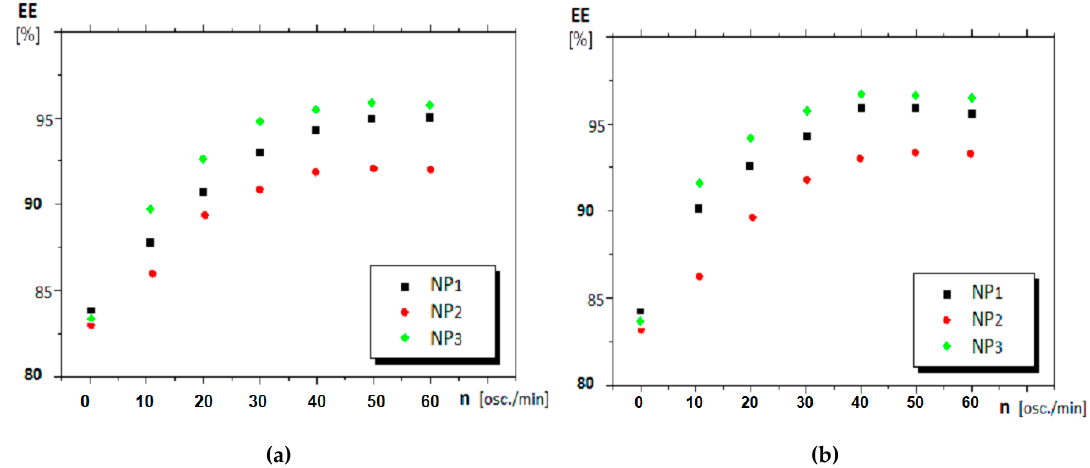
Figure 7. The variation of extraction efficiency for o- nitrophenol after 20 min of operating with nanoparticles dispersed against the stirring regime in the two considered alcohols: ( a ) n -octanol and ( b ) n -decanol.